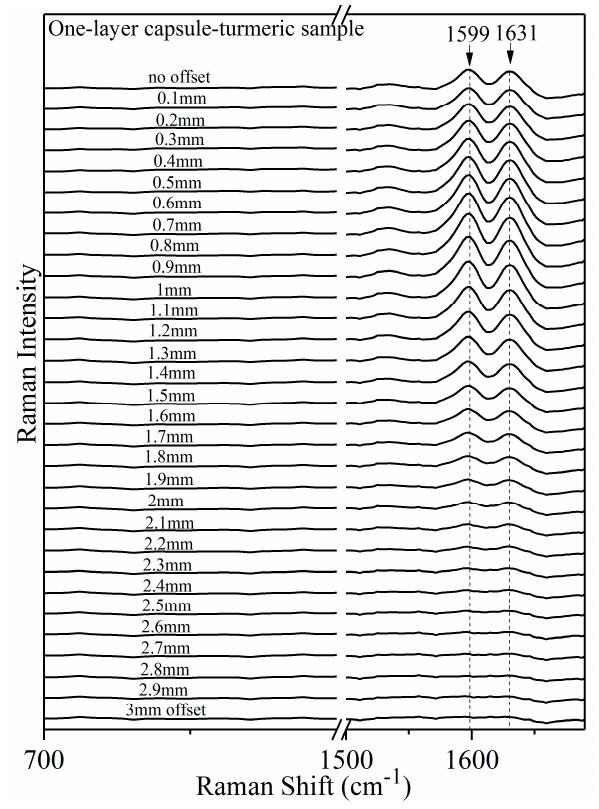
Figure 9. Spatially offset Raman spectra of turmeric powder packaged inside one-layer capsule.